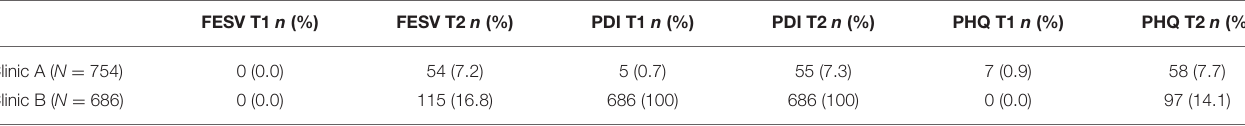
TABLE 1 | Missing data in both